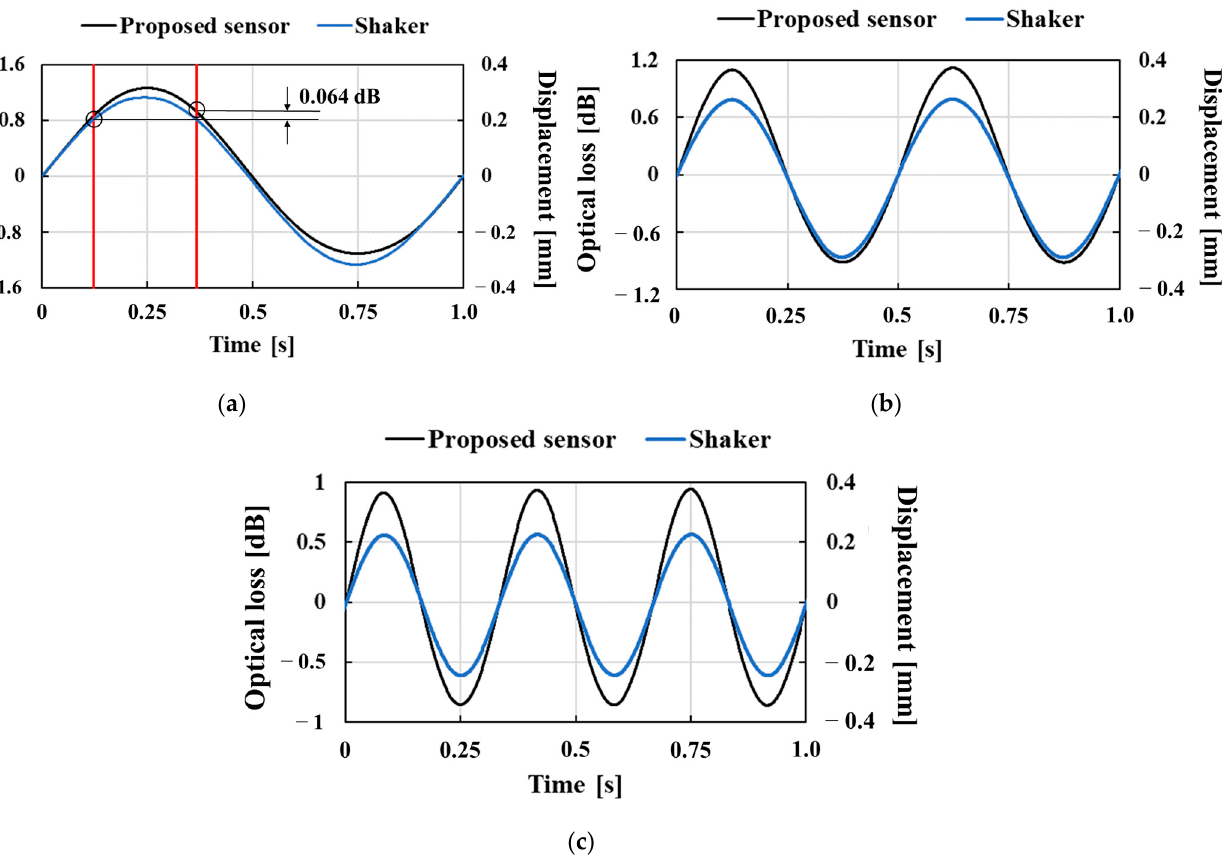
Figure 7. Dynamic characteristics of the hetero-core fiber-optic pressure sensor with the puff applied to sinusoidally time-varying pressure at frequency: ( a ) 1, ( b ) 2, and ( c ) 3 Hz.